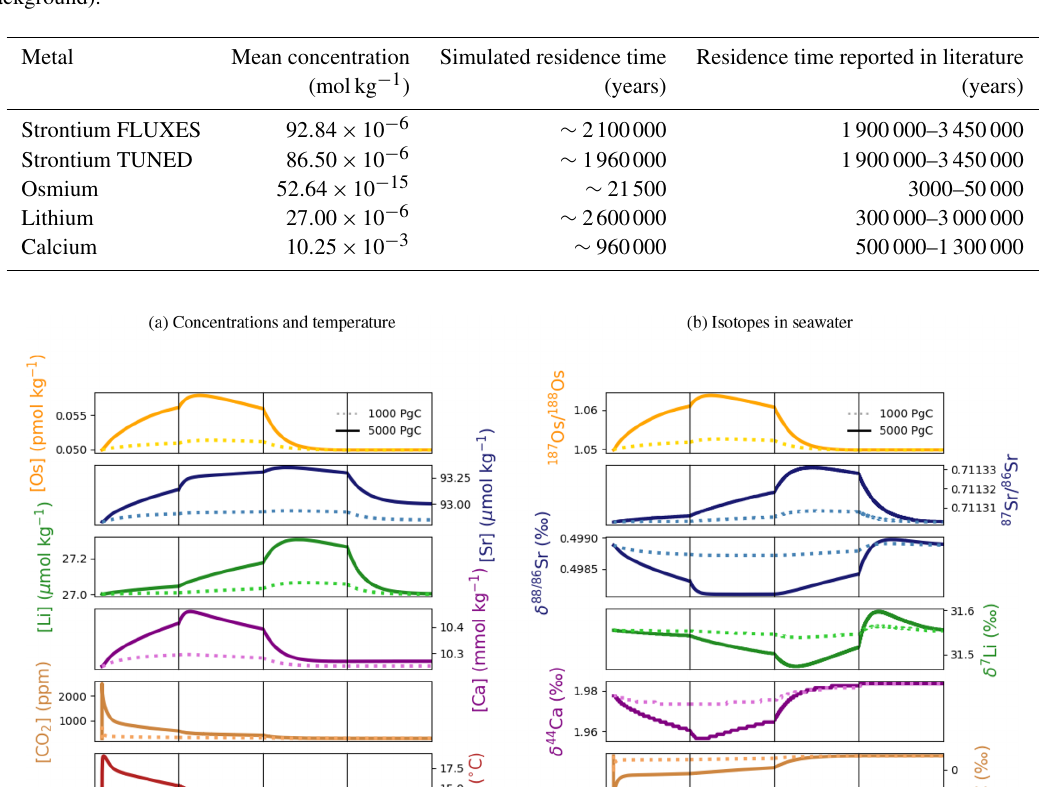
Table 7. Marine trace metal concentrations and residence times in our pre-industrial spin-up compared to those reported in literature (see scientific background).